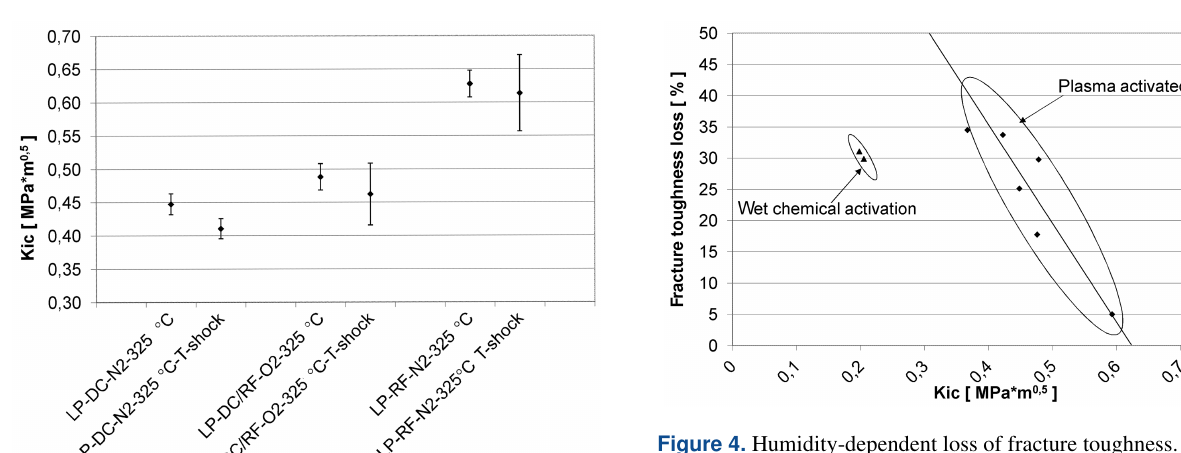
Figure 4. Humidity-dependent loss of fracture toughness.